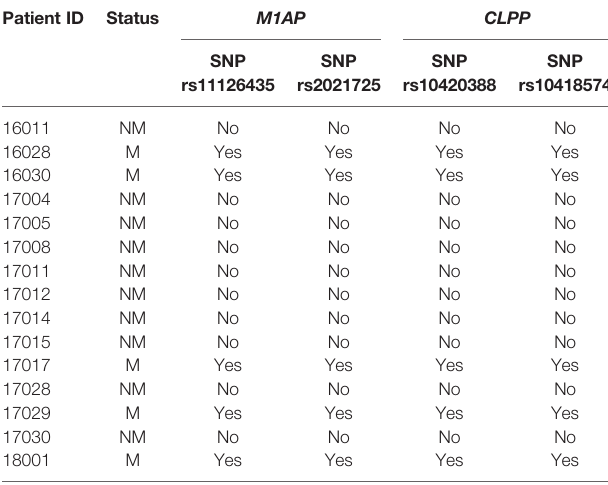
“ NM ” indicates genotype in non-metastatic patients. “ M ” indicates genotype in metastatic patients. “ Yes ” indicatesthepatientcontainsthisSNP,while “ No ” indicatesthepatienthas the same genotype as reference